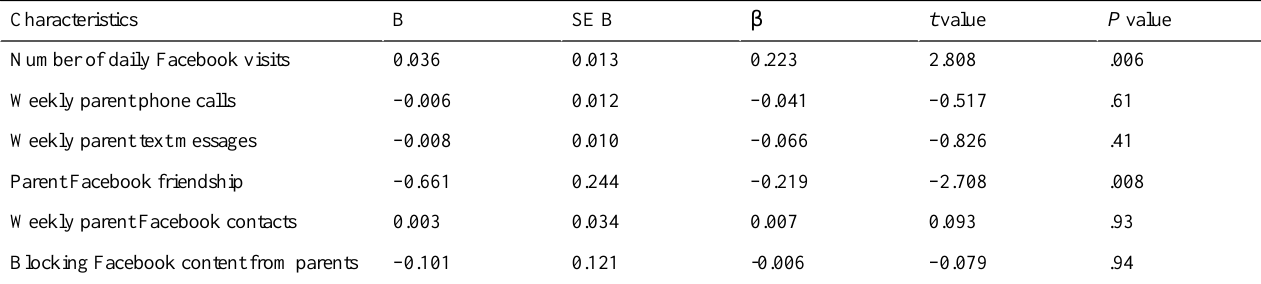
Table 2. Predictors of risk of problematic internet